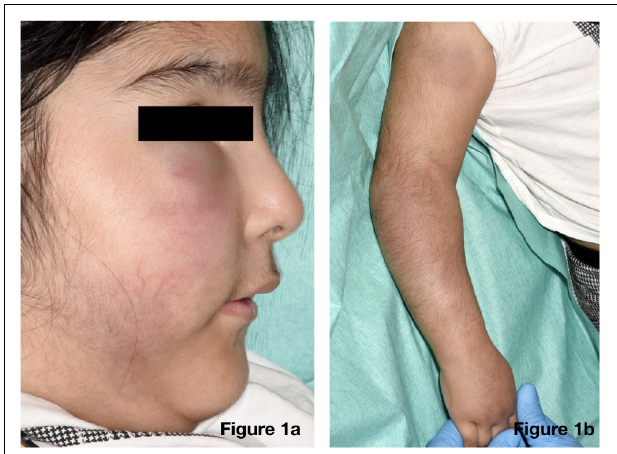
FIGURE 1 | Physical examination revealed dusky indurated plaques on the central and lower face (a) and arms (b) with associated oedema.